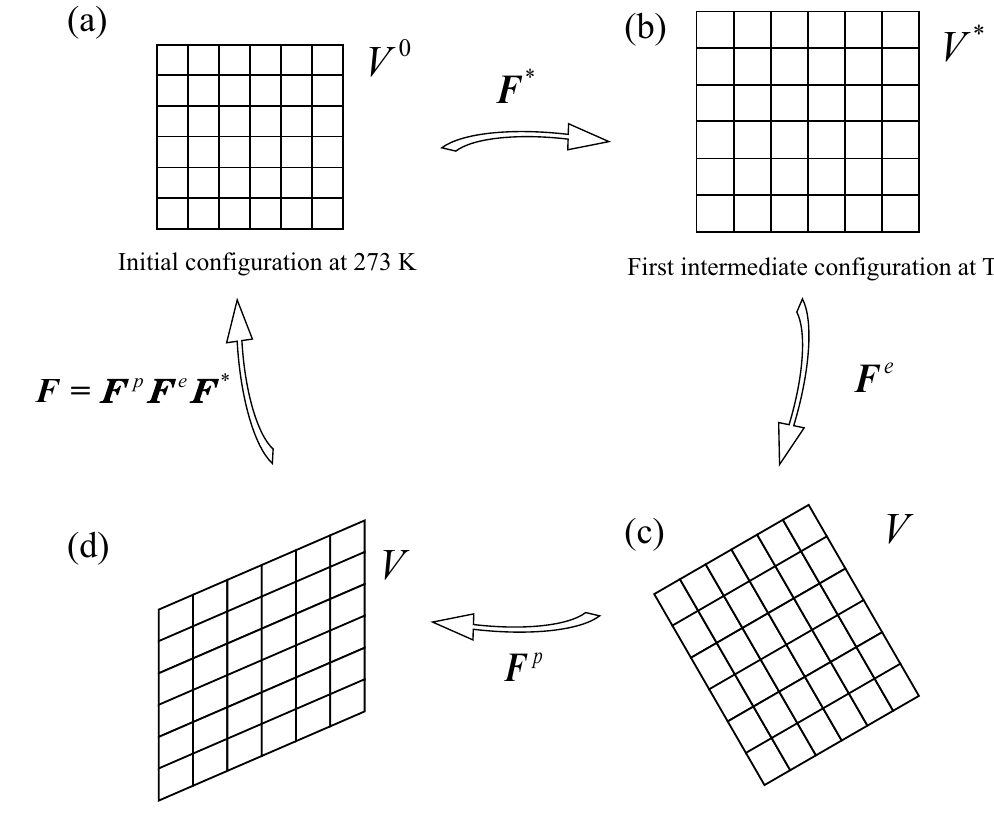
Figure 1. Decomposition of deformation configuration: ( a ) initial configuration; ( b ) first intermediate configuration; ( c ) second intermediate configuration; ( d ) current